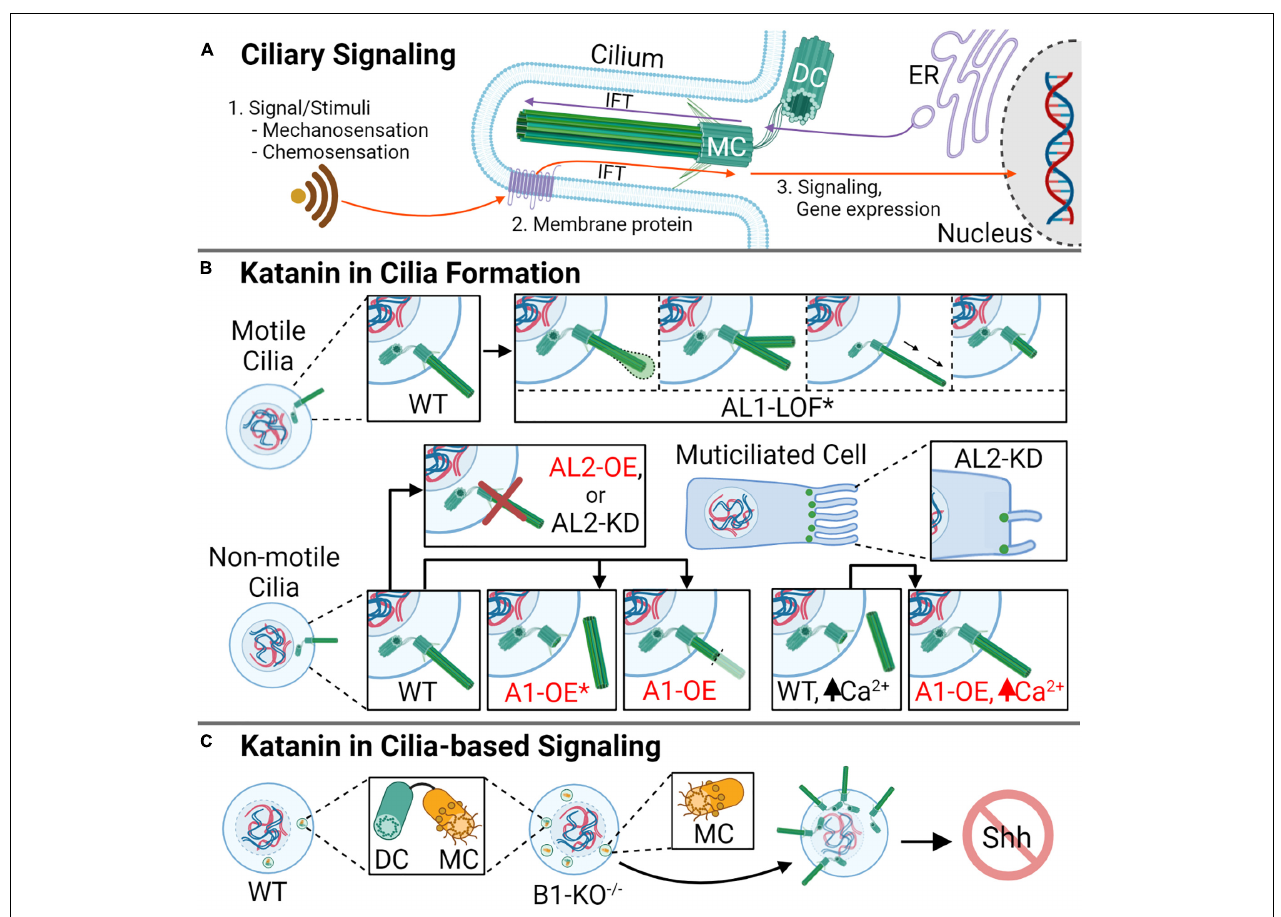
FIGURE 3 | Katanin function in ciliogenesis and cilia resorption. (A) Cilia are important microtubule-based organelles important for cell signaling during development. (B) In motile cilia, AL1-LOF* (asterisk denoting the mutation AL1 1H / 1H ) causes a variety of defects, including swelling at the ciliary tip, ciliary bifurcation, elongation, and shortening, causing defective ciliary movement. In non-motile ciliated cells, A1 overexpression (OE) promotes cilia disassembly, with rapid deciliation as the favored method (indicated by asterisk). In cells with high levels of Ca 2 + , which signals deciliation, A1-OE prevents the loss of cilia. Knockdown or overexpression of AL2 in non-motile cilia causes a reduction in ciliogenesis, while in multiciliated cells, AL2 KD reduces cilia number and reduces cilia length. KD of AL2 to levels below 50% or AL2 OE triggers apoptosis (not shown). (C) Homozygous knockout of B1 (B1-KO – / – ) leads to the generation of supernumerary centrioles, excess mother centrioles, aberrant ciliation, and disrupted cellular signaling, including sonic hedgehog (Shh) signaling. DC indicates daughter centriole, and MC indicates mother centriole.